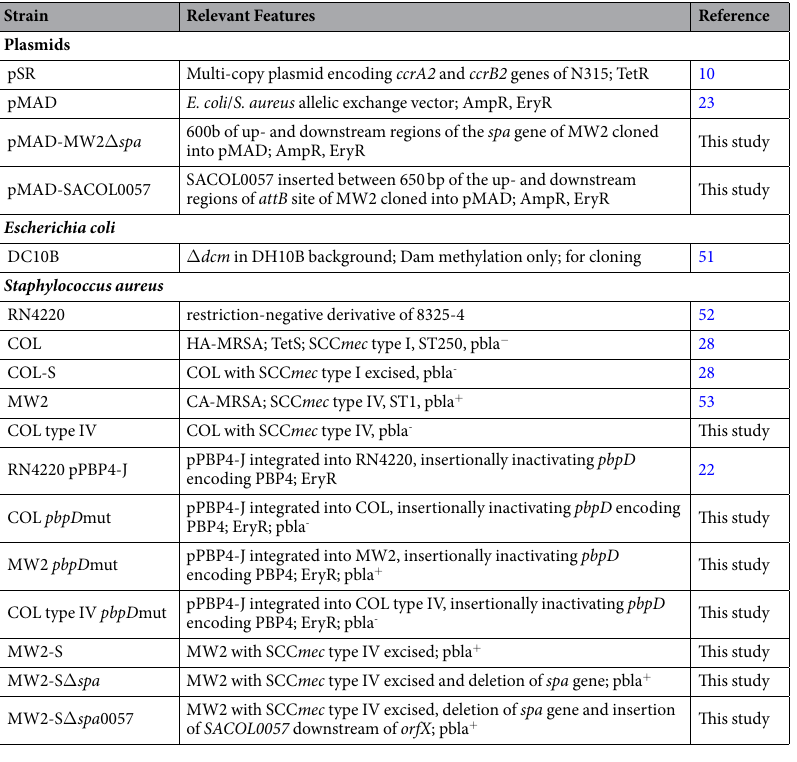
Table 1. Bacterial strains used in this